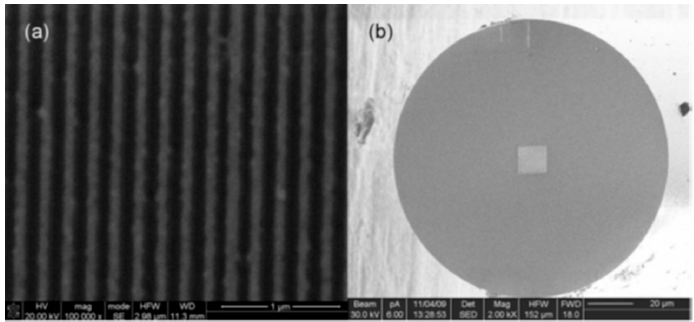
Figure 28. ( a ) Detail of the gold grid fabricated on the tip of a SMF; ( b ) SEM image of the sensor head: the square grid is appreciable at the centre of the fibre. Reprinted from [143].